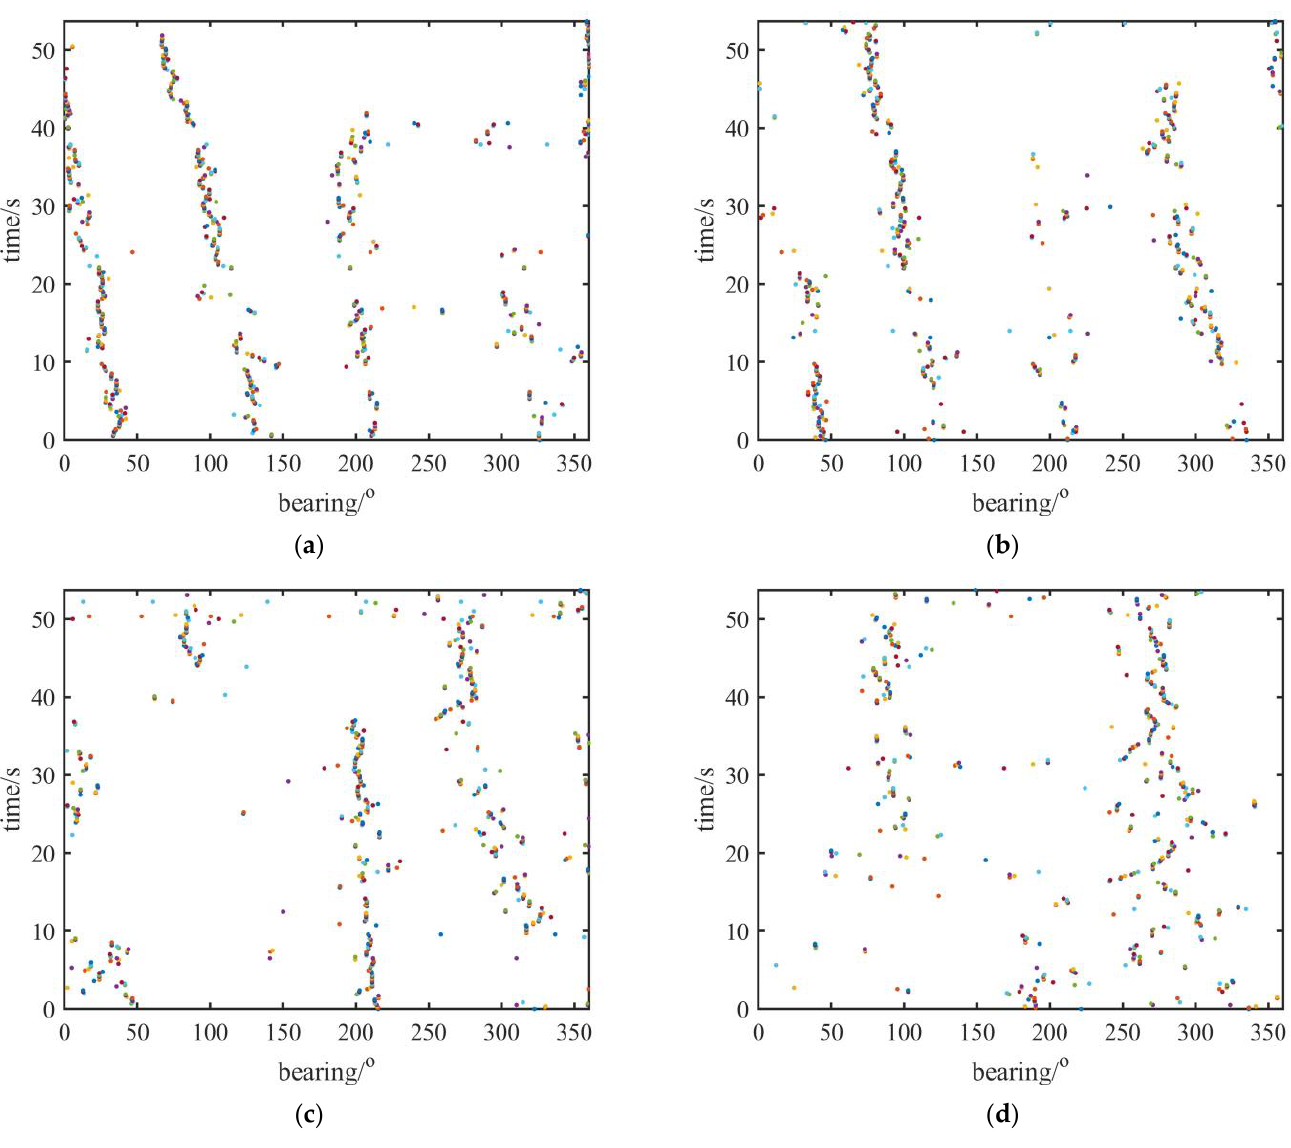
Figure 4. Traces of the boats in the first – fourth mode: ( a ) traces of boats in mode 1; ( b ) traces of boats in mode 2; ( c ) traces of boats in mode 3; ( d ) traces of boats in mode 4.